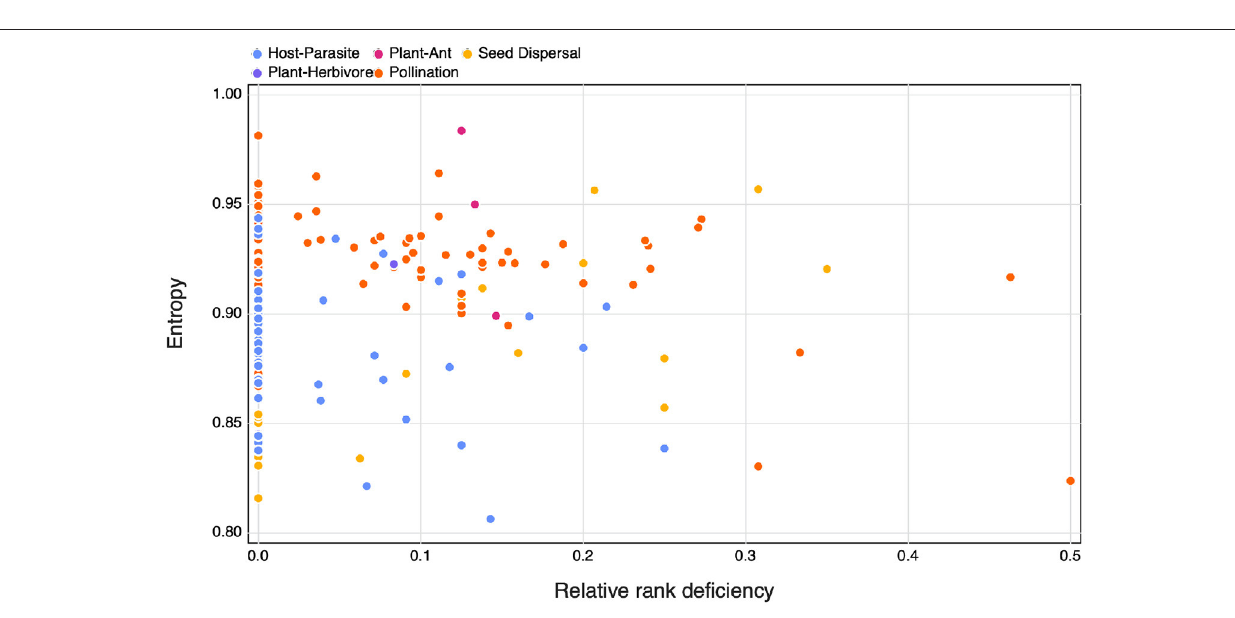
FIGURE 2 | The relationship between SVD entropy and the relative rank deficiency of different species interaction networks colours indicate the different interaction types of the